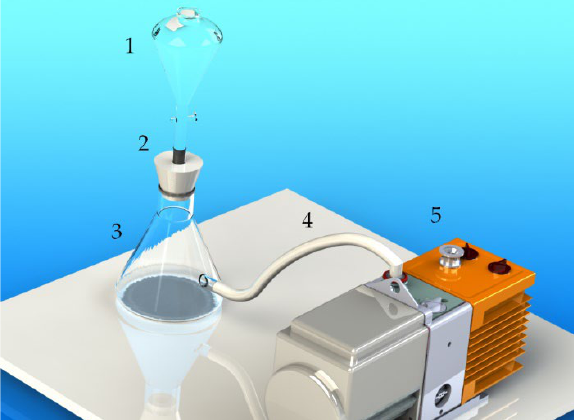
Figure 2. Schematic diagram of the filter cake solidification device. 1—separation funnel; 2—sam- pler; 3—filter bottle; 4—rubber tube; 5—vacuum pump. 3—filter bottle; 4—rubber tube; 5—vacuum